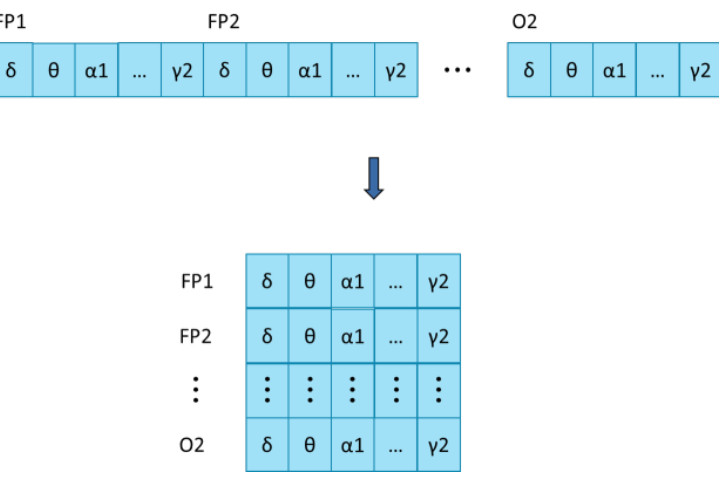
Figure 3. 1D data transformed into 2D data.